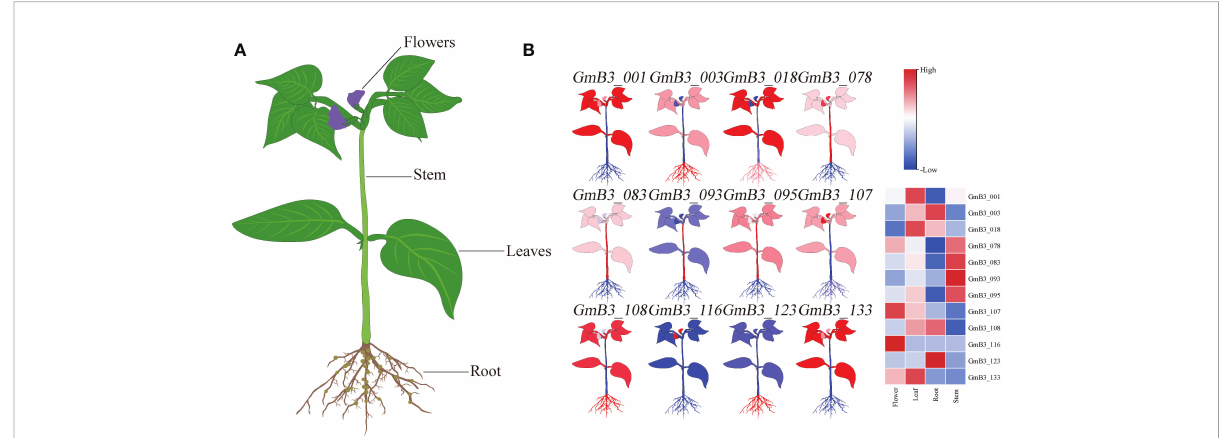
FIGURE 8 Expression pro fi les of GmB3 genes in different tissues. (A) The schematic diagram of different tissues of soybean. (B) The signi fi cant expression of 12 GmB3s in different tissues. The expression level were based on the transcriptome